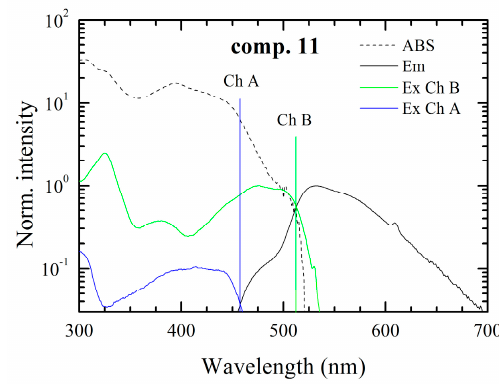
Figure 2. UV-Vis absorption, excitation and emission spectra of the compounds considering two-chromophore model with the marked optical band gaps of observed chromophores.